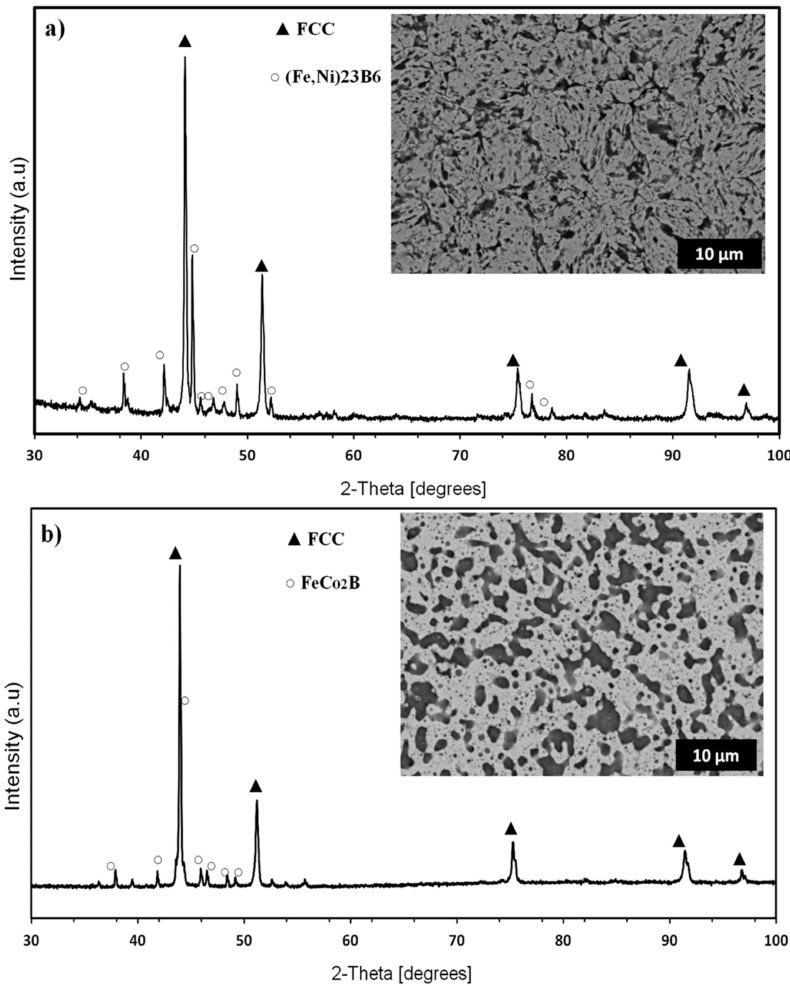
Figure 8. X-ray di ff raction pattern and the scanning electron micrographs of the HEA at the two temperatures, ( a ) SPS at 750 ◦ C and ( b ) SPS at 1000 ◦ C.